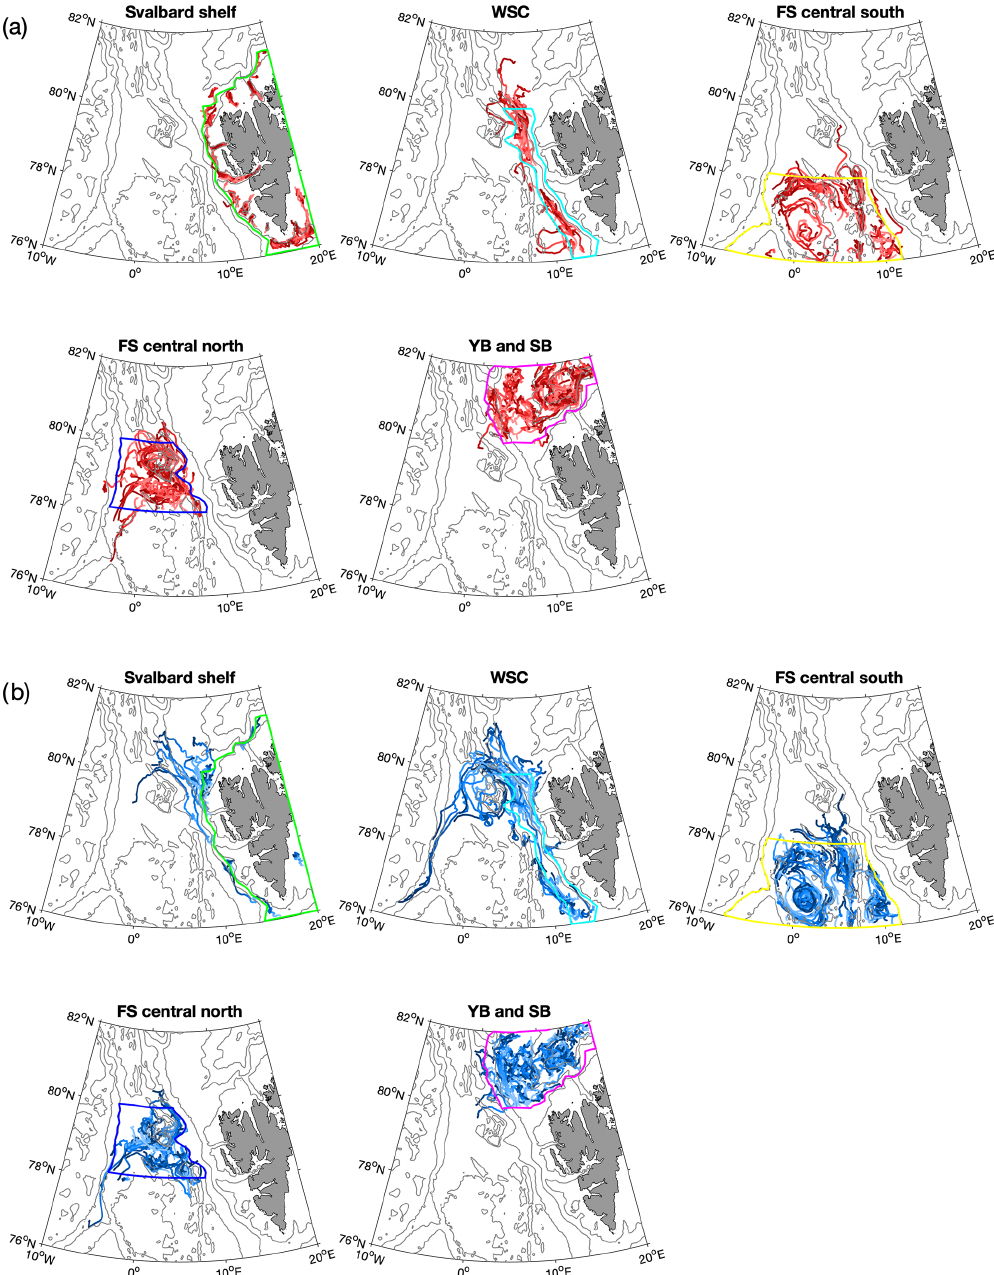
Figure 8. Eddy tracks of cyclones (red lines, a ) and anticyclones (blue lines, b ) with lifetimes of more than 30d that are generated in five different regions indicated by coloured polygons (see Fig. 1) detected in ROMS simulations from 2006 to 2009. Light and dark colours of the lines indicate the beginning and end of the track,